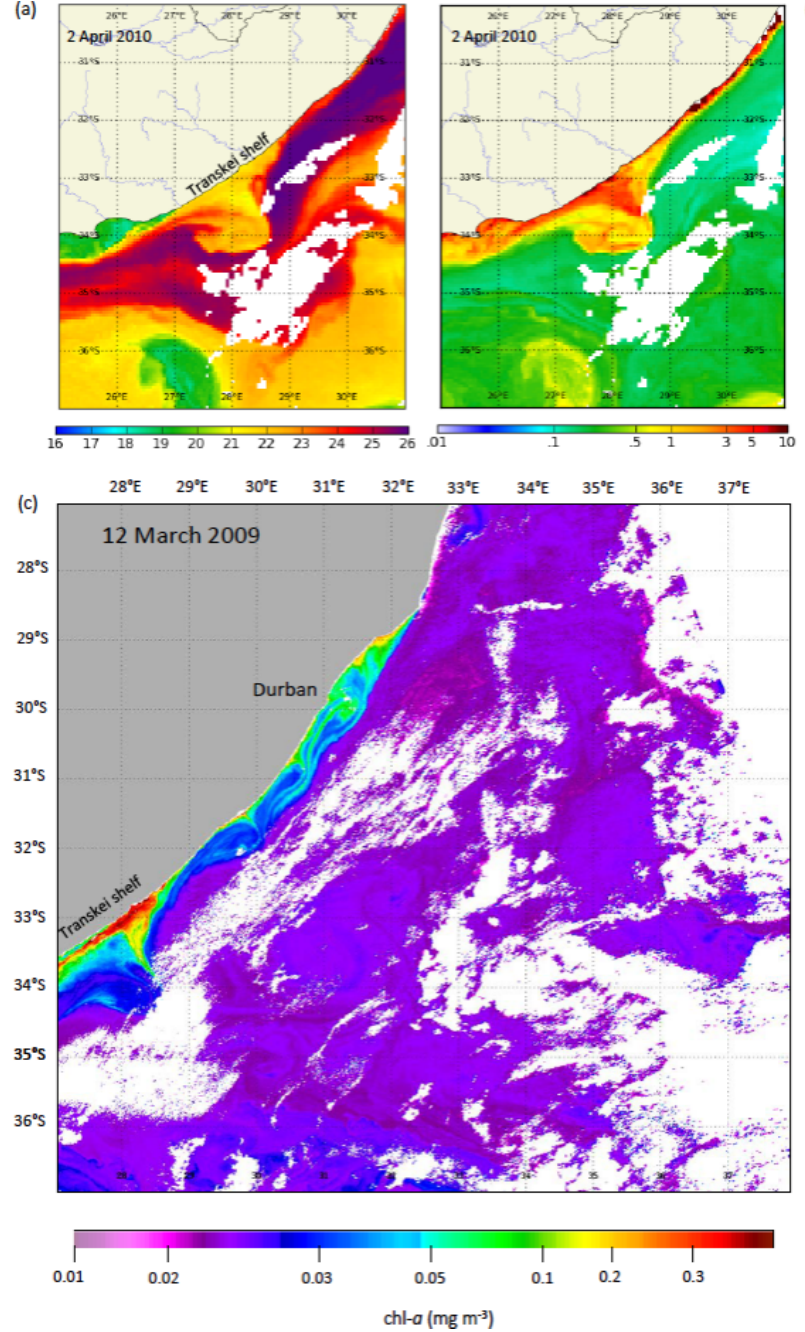
Figure 5. Satellite SST (LHS) and chlorophyll a (RHS) images of a Natal pulse on 2 April 2010 off the narrow Transkei shelf. Note the high levels of chl a on the eastern side of the cyclone (meander) which protrude off the shelf.